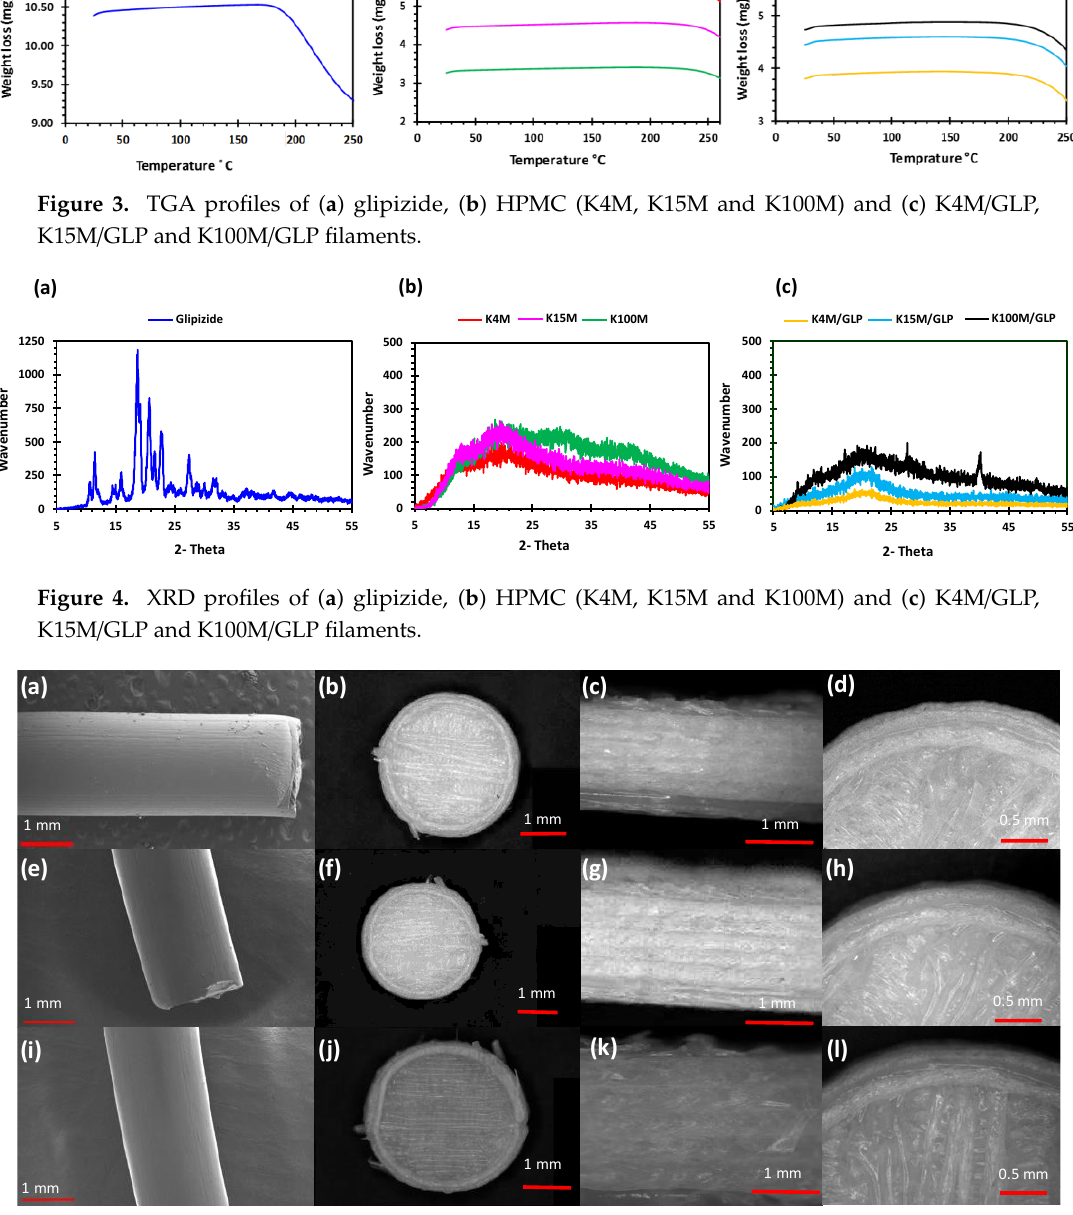
Table 3. Drug loading and three-point bending results of filaments (* n = 10, standard deviations are in parenthesis) .